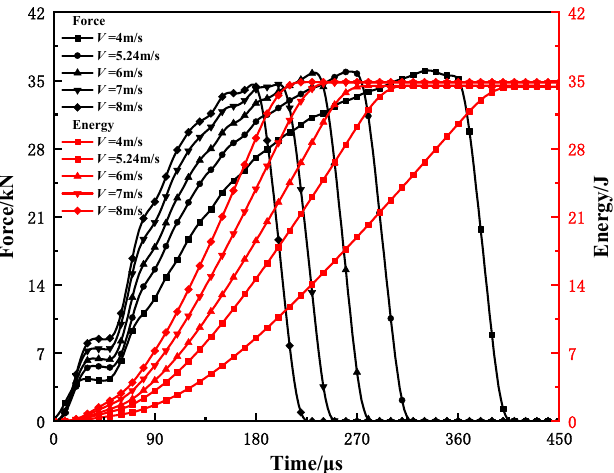
Figure 16. Influence of striker velocity on load–time and energy–time curves.